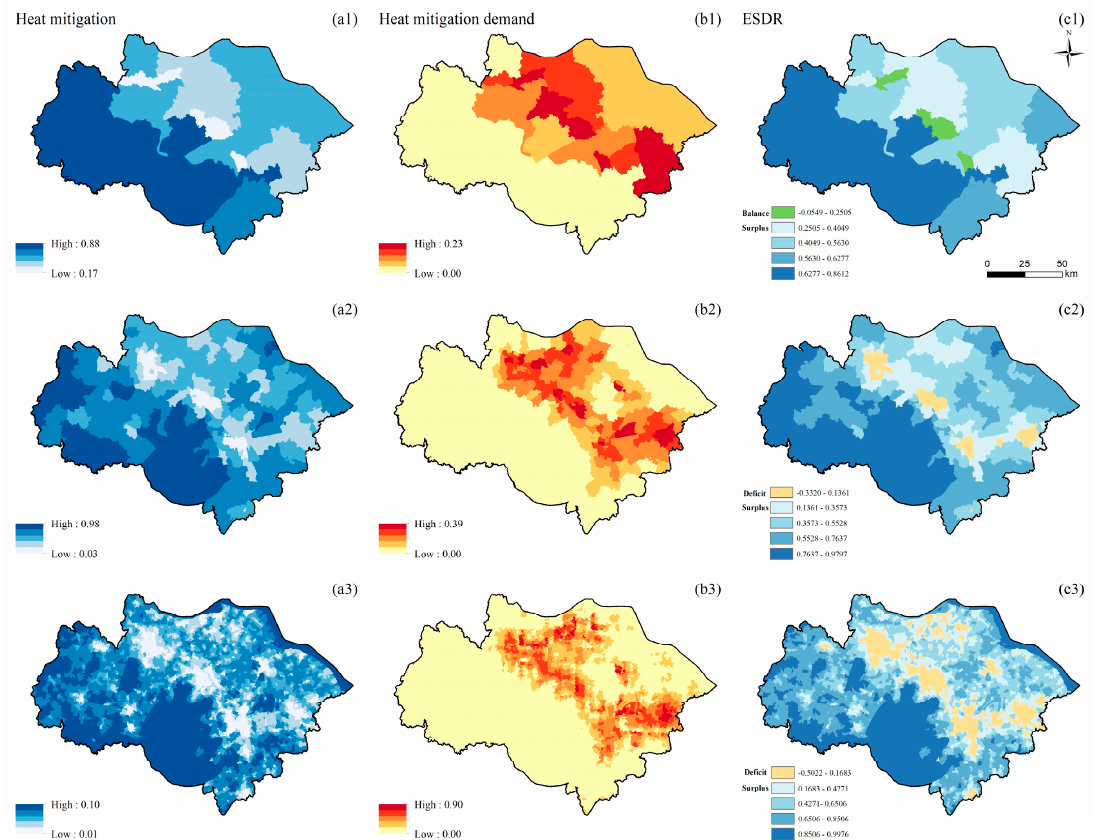
Figure 6. Spatial distribution of HM (unit: dimensionless, the value is between 0–1) at the county ( a1 , b1 , c1 ), township ( a2 , b2 , c2 ), and village ( a3 , b3 , c3 ) scales; supply of HM ( a1 – a3 ); demand for HM ( b1 – b3 ); ESDR ( c1 – c3 ).